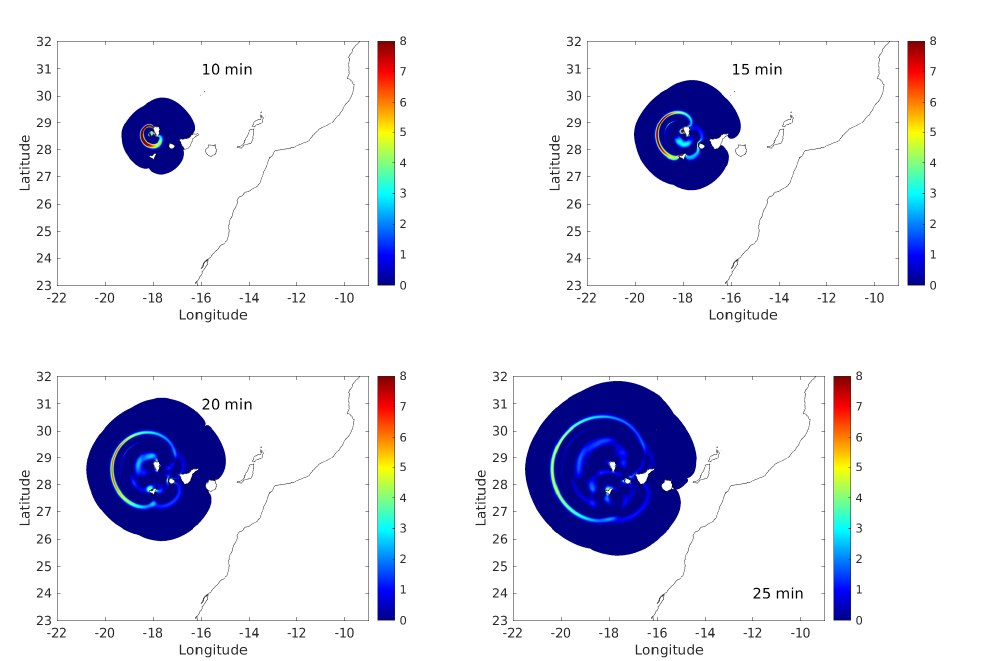
Figure 3. Snapshots of sea surface elevation at different times after a slide of material along the island slope.